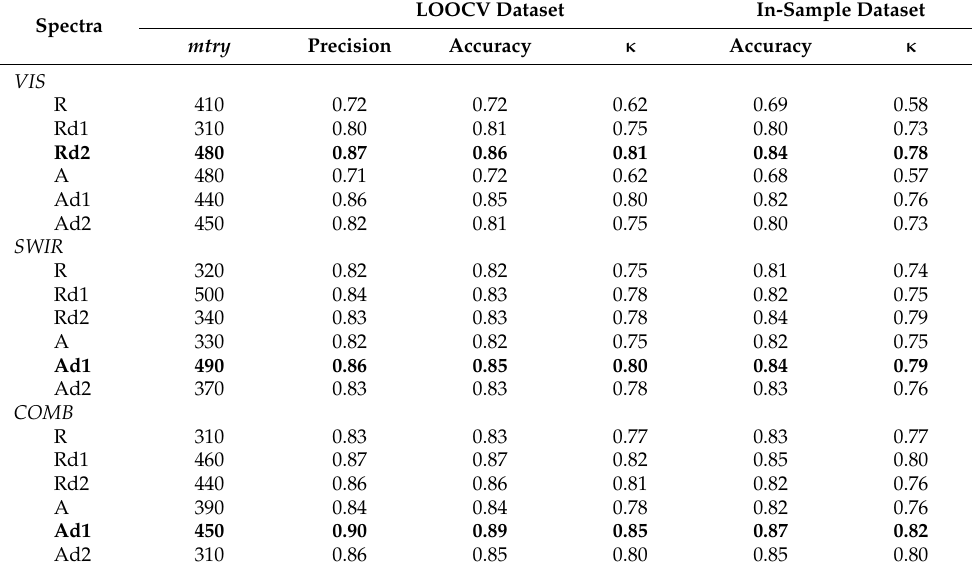
Table 5. Random forest algorithm classification accuracy and coefficient of agreement (Kappa, κ ) from visible (VIS), short-wave infrared (SWIR) and combination VIS and SWIR (COMB) hyperspectral sensors to differentiate bovine and ovine hearts, kidneys, livers and lungs on the leave-one-out cross validation (LOOCV) and in-sample datasets.